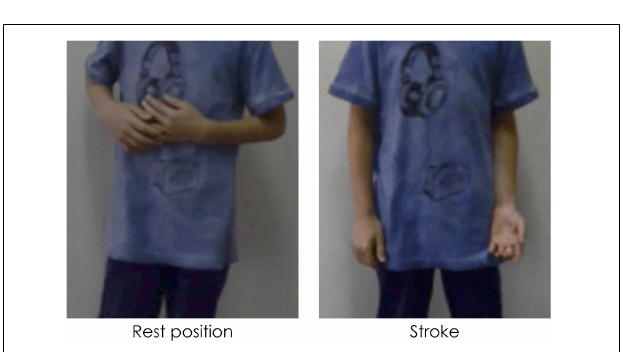
FIGURE 3 | Caption of a non-referential gesture while saying “hi havia el MATEIX ANIMAL” (“there was the SAME ANIMAL”). Capitalization